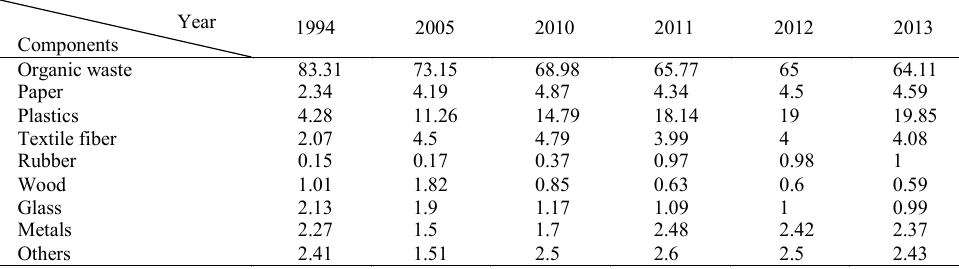
Table 2: Materials discarded in the municipal waste stream (percent of total